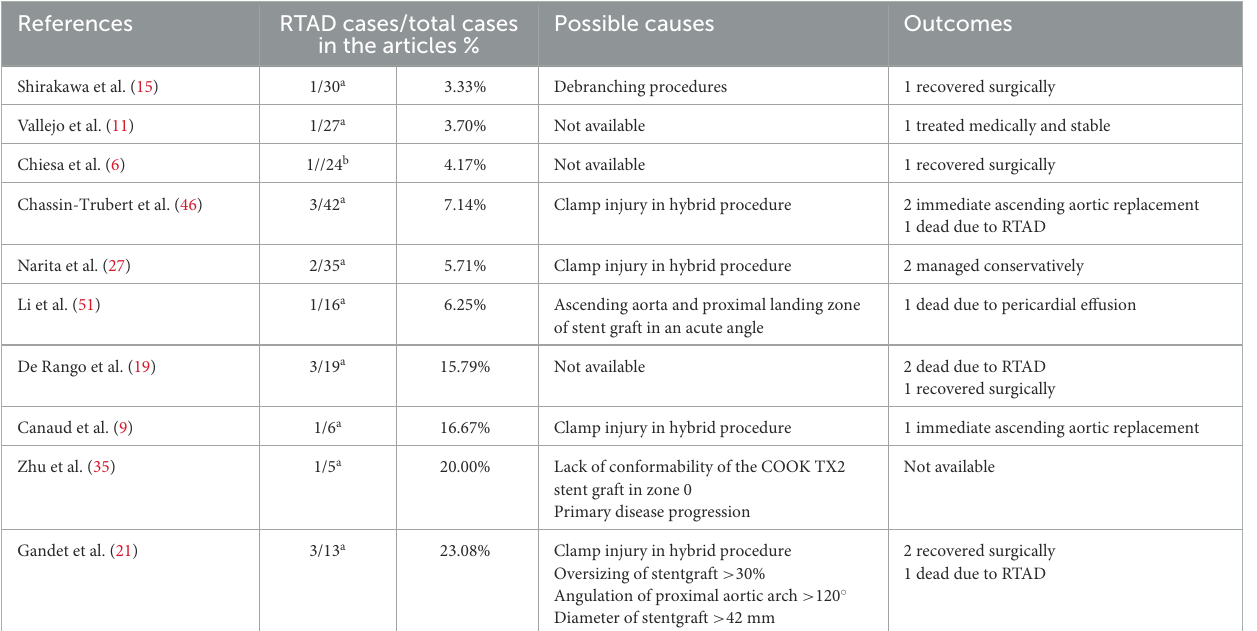
TABLE 9 Possible causes and outcomes of RTADs in included